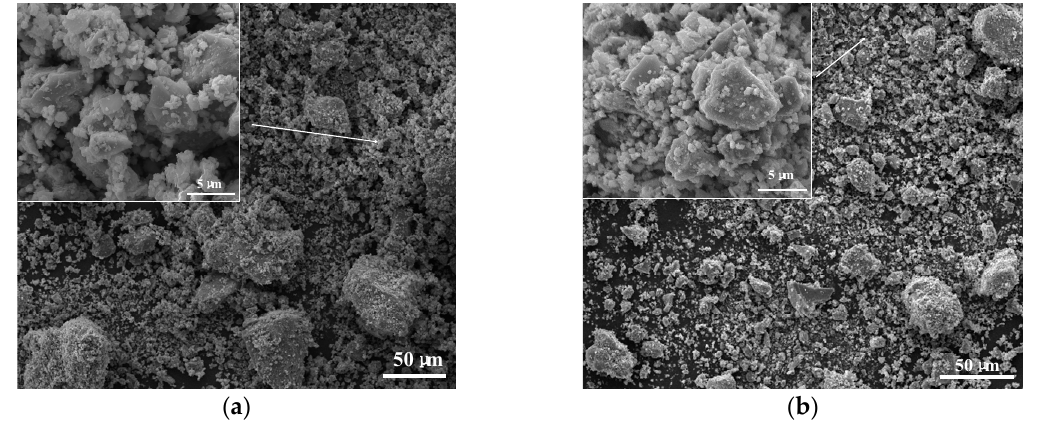
Figure 8. Particle morphology of ground steel slag powder after 50min grinding time: ( a ) untreated steel slag; ( b ) pretreated steel slag.